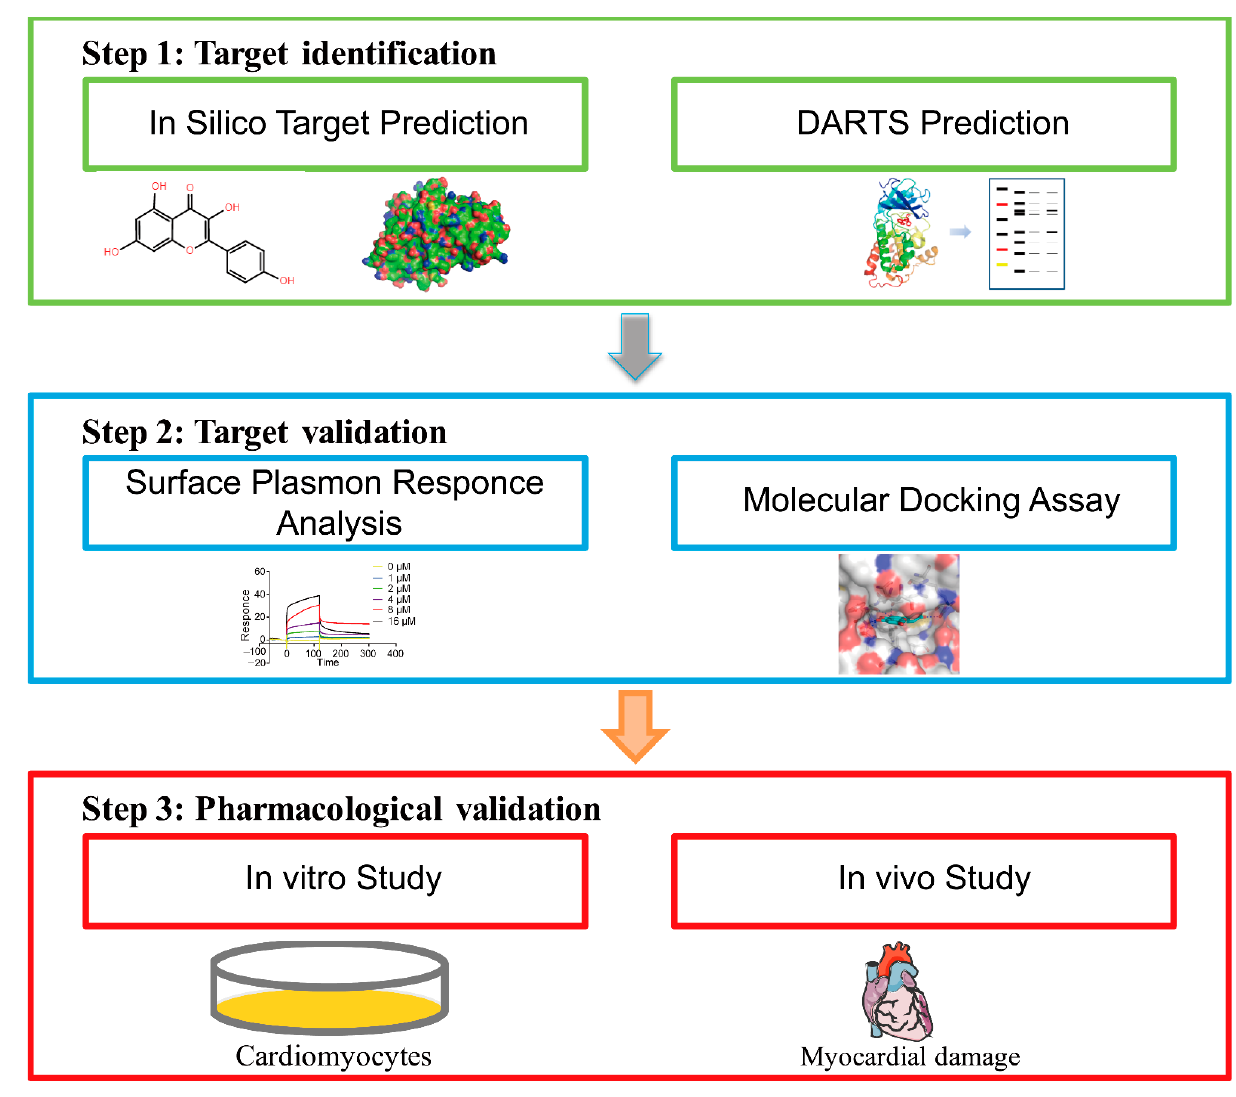
Figure 1. The flow diagram of target characterization of Kae against myocardial infarction using comprehensive in silico docking and DARTS prediction strategy.